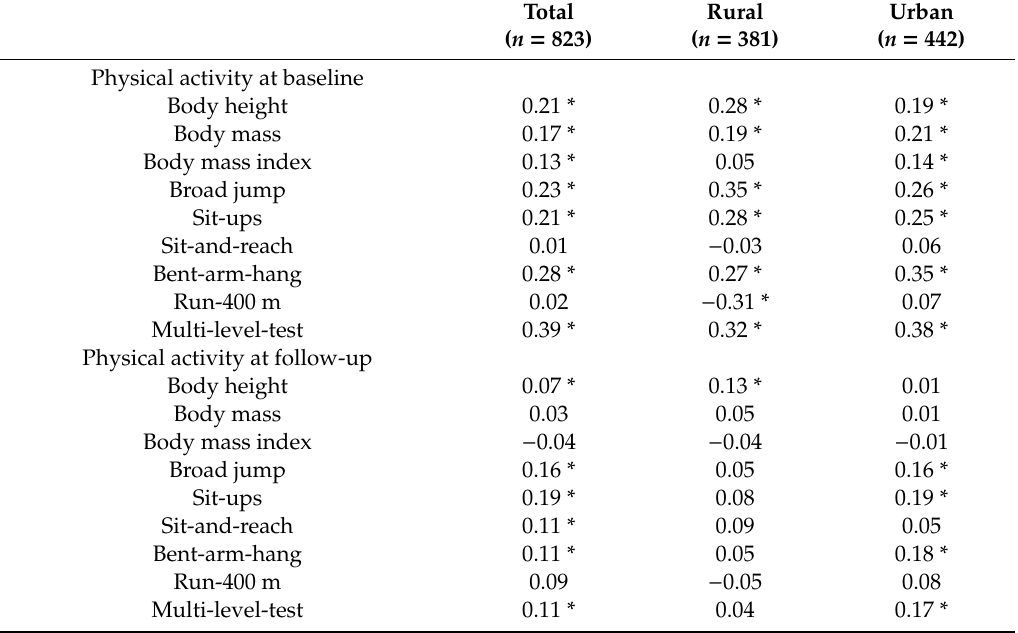
Table 2. Pearson’s product moment correlation coefficients between anthropometric, physical fitness, and physical-activity-level variables (* indicates significant correlation at p < 0.05).